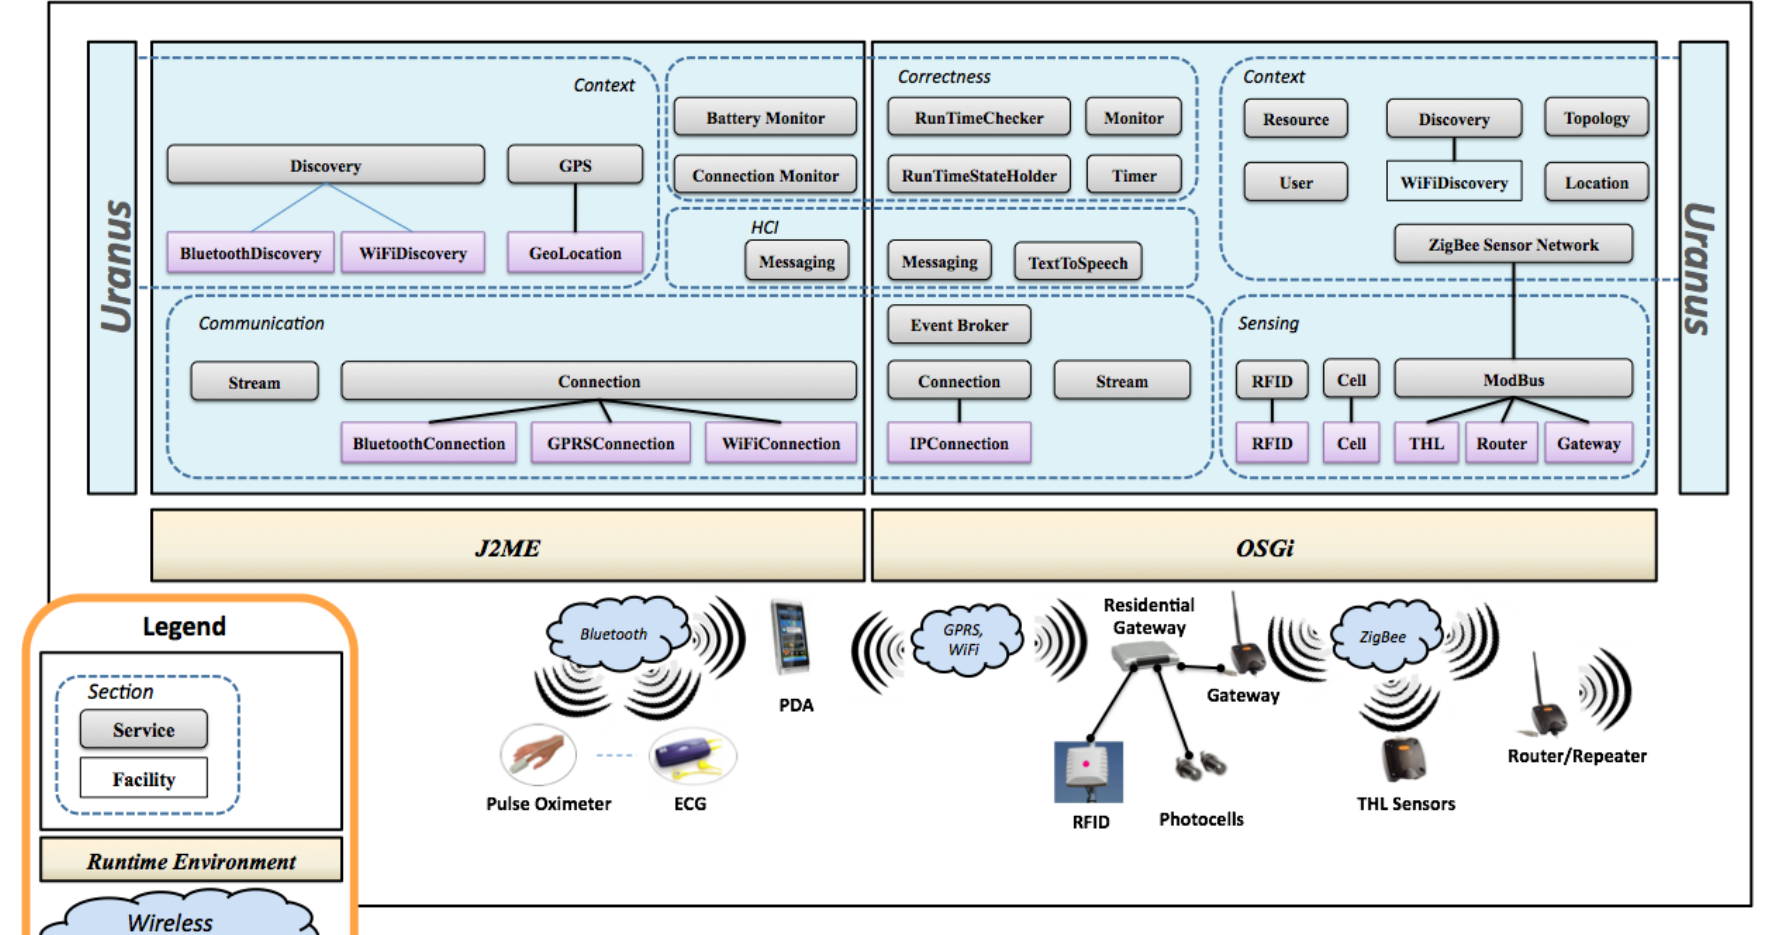
Figure 1. Uranus